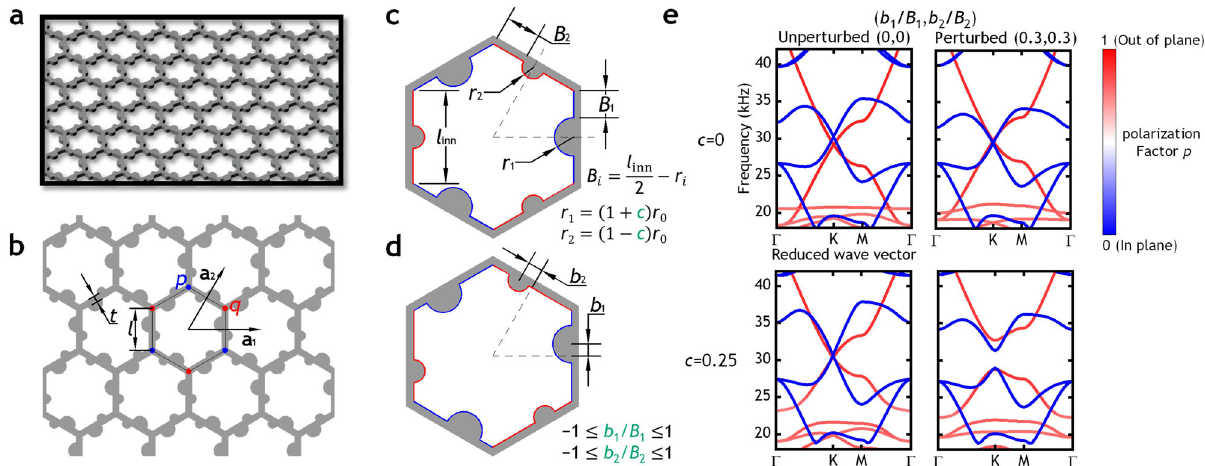
Fig. 1 Designed phononic crystals with three tunable geometric parameters and their energy band structures. a , b Perspective view ( a ) and top view ( b ) of a two-dimensional phononic crystal with periodic hexagonal-like holes made of the linear elastic material having properties of acrylic plastic. Black solid hexagon is a primitive cell with side length l = 10 mm, and a 1 and a 2 are lattice vectors of the crystal. p and q indicate two inequivalent triangular sublattices. c , d Detailed schematics of the primitive cell without ( c ) and with ( d ) the perturbations, nonzero ( b 1 / B 1 , b 2 / B 2 ). Three tunable parameters, nondimensionalized radius difference c and perturbation variables b 1 / B 1 and b 2 / B 2 , are green-colored. e Energy band structures of the phononic crystal for various geometric parameters. The polarization factor of each state is indicated by color, blue for polarization factor 0 (purely in-plane polarized state) and red for polarization factor 1 (purely out-of-plane polarized state). The extended version of ( e ) is in Supplementary Fig.